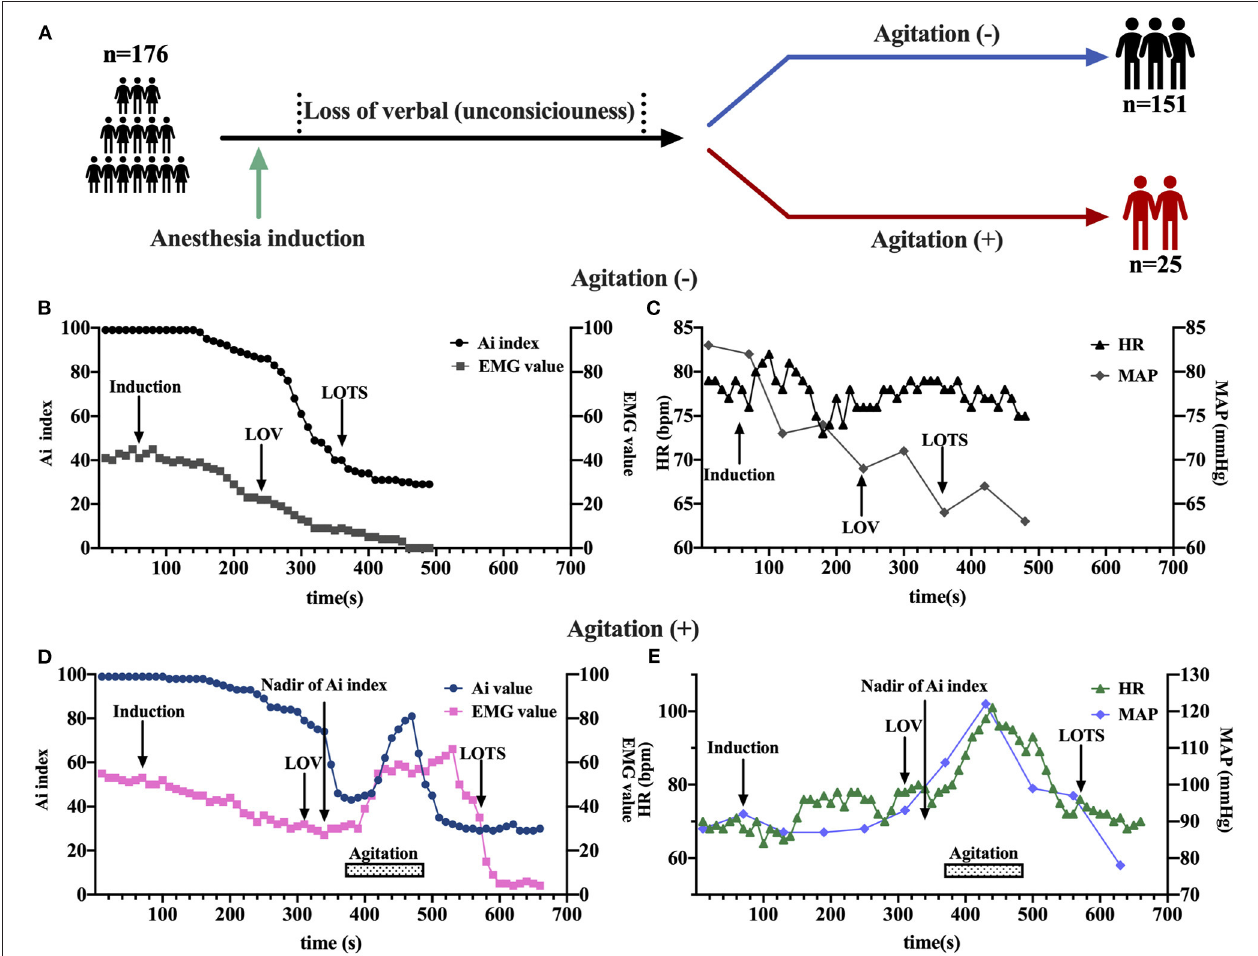
FIGURE 2 | The schematic of the anesthesia induction protocol and data from two illustrative subjects. (A) Sevoflurane was administered to anesthesia induction. (B–E) Examples of time course of Ai index, electromyography (EMG), Heart rate (HR), and mean arterial pressure (MAP) during sevoflurane induction at baseline, loss of verbal (LOV), loss of response to trapezius squeeze (LOTS), and agitation behavior in two groups with either the occurrence of agitation (D,E) or not (B,C) . The LOV, LOTS, Nadir of Ai index and agitation period were shown. EMG, electromyography; Ai index, the depth of anesthesia index; MAP, mean arterial pressure; HR, heart rate; LOV, loss of verbal; LOTS, loss of response to trapezius